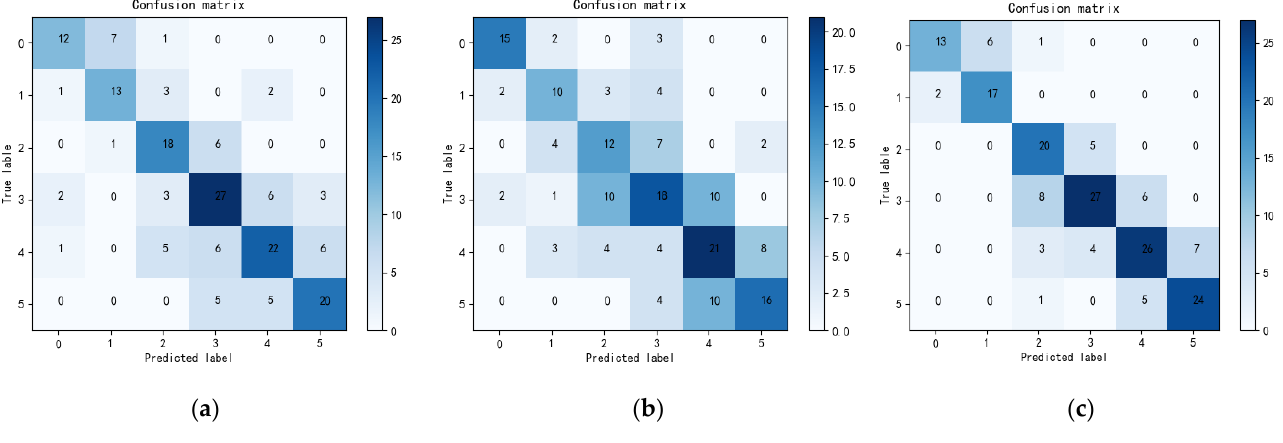
Table 4. Comparison of the method introduced in this paper with other classification models with respect to the M 2 module. We performed two experiments for each model. The first row of experi- mental results for each model presents the results without the M 2 module. The second row presents the experimental results using the M 2 module.